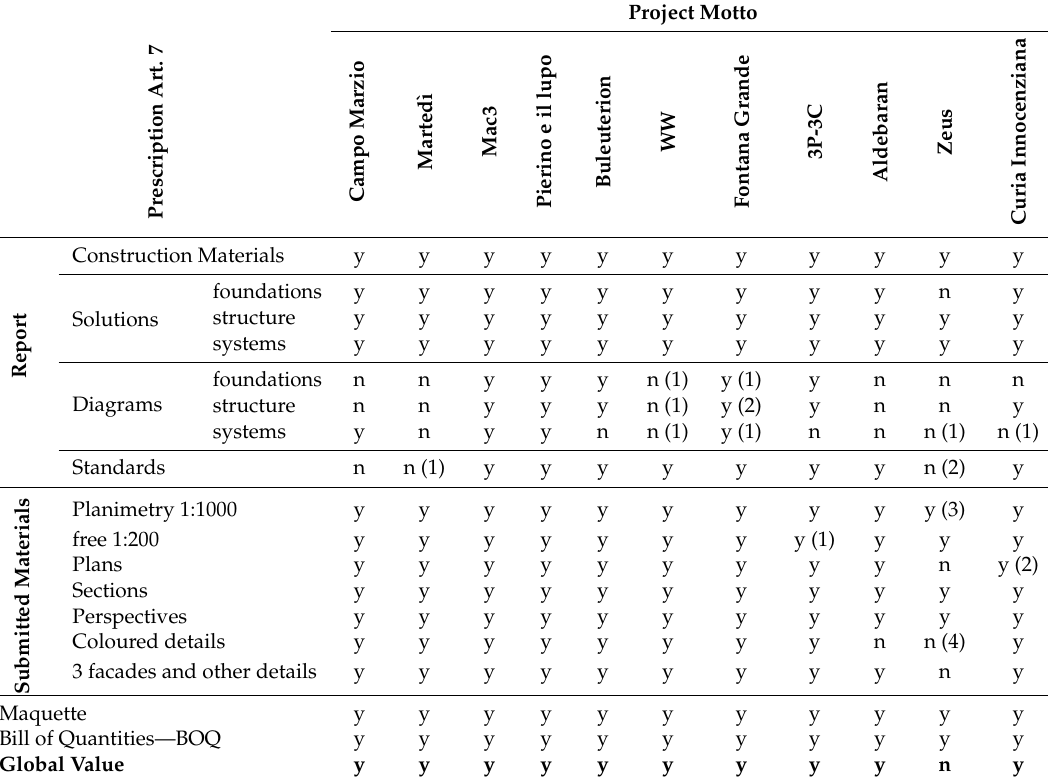
Table 5. Example of the quantitative criterion: “Relevance to the rules (art. 7)”—data from the 1967